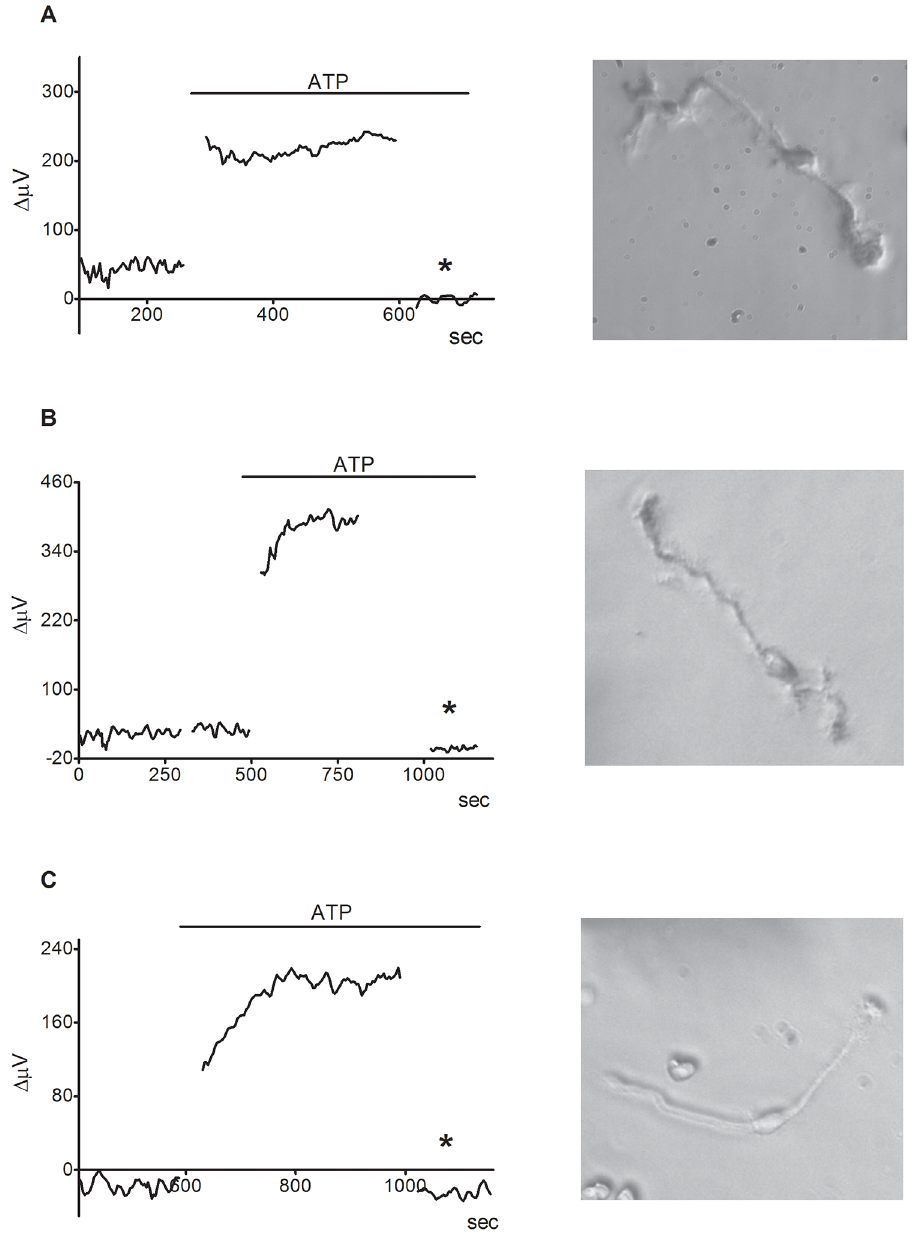
Fig 4. 100 μM ATP causes an increase in extracellular H+ flux from isolated Mu¨ller cells from human retina (A), Sprague-Dawley rat retina (B) and lamprey retina (C). An image of an isolated Mu¨ller cell from each species is to the right of each respective